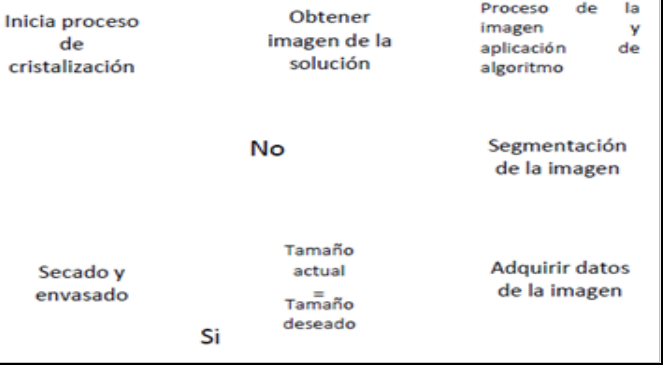
Figura 4: Diagrama de flujo del proceso de cristalización y procesamiento de la imagen.